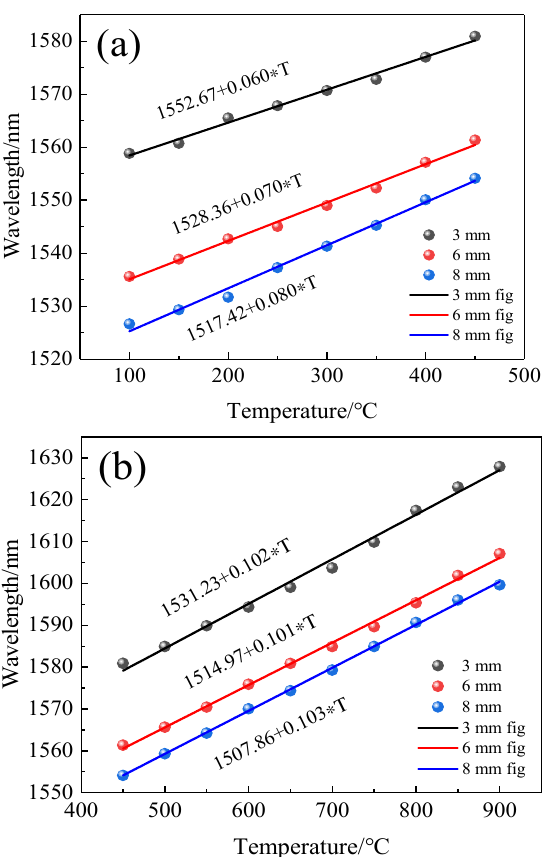
Figure 12. Temperature sensitivity of the MI structure with different lengths (L). ( a ) low-temperature region (100 °C~450 °C); ( b ) high-temperature region (450 °C~900 °C).